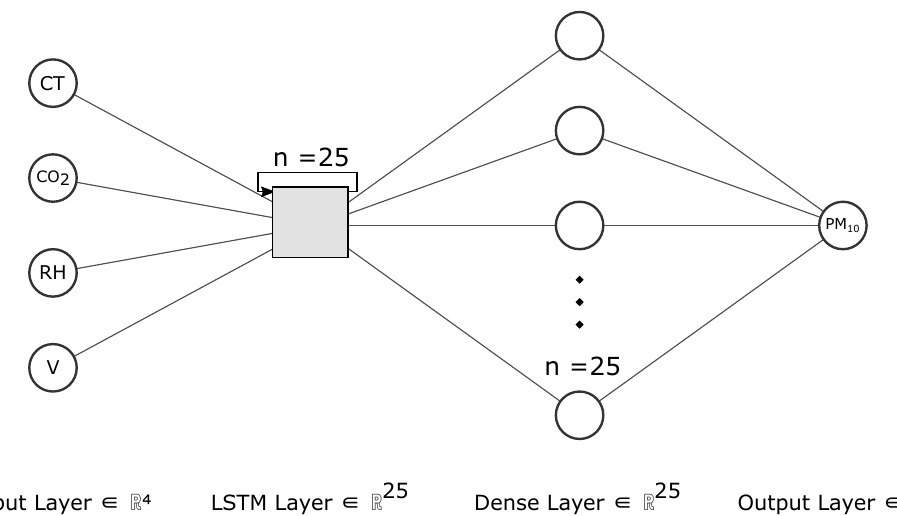
Figure 8. Long Short-Term Memory (LSTM) schematic with 4 inputs and 1 dense layer. The models were trained with different amount of data starting from 20% to 80%. The models did not overfit until 40%, as the results continue to get better with the increase in the amount of training data. Models showed little betterment with increase in training data above 40%. The computational time increases drastically with the increase in training data above 40% for LSTM and FFNN, so 40% training data was the ideal choice to compare the